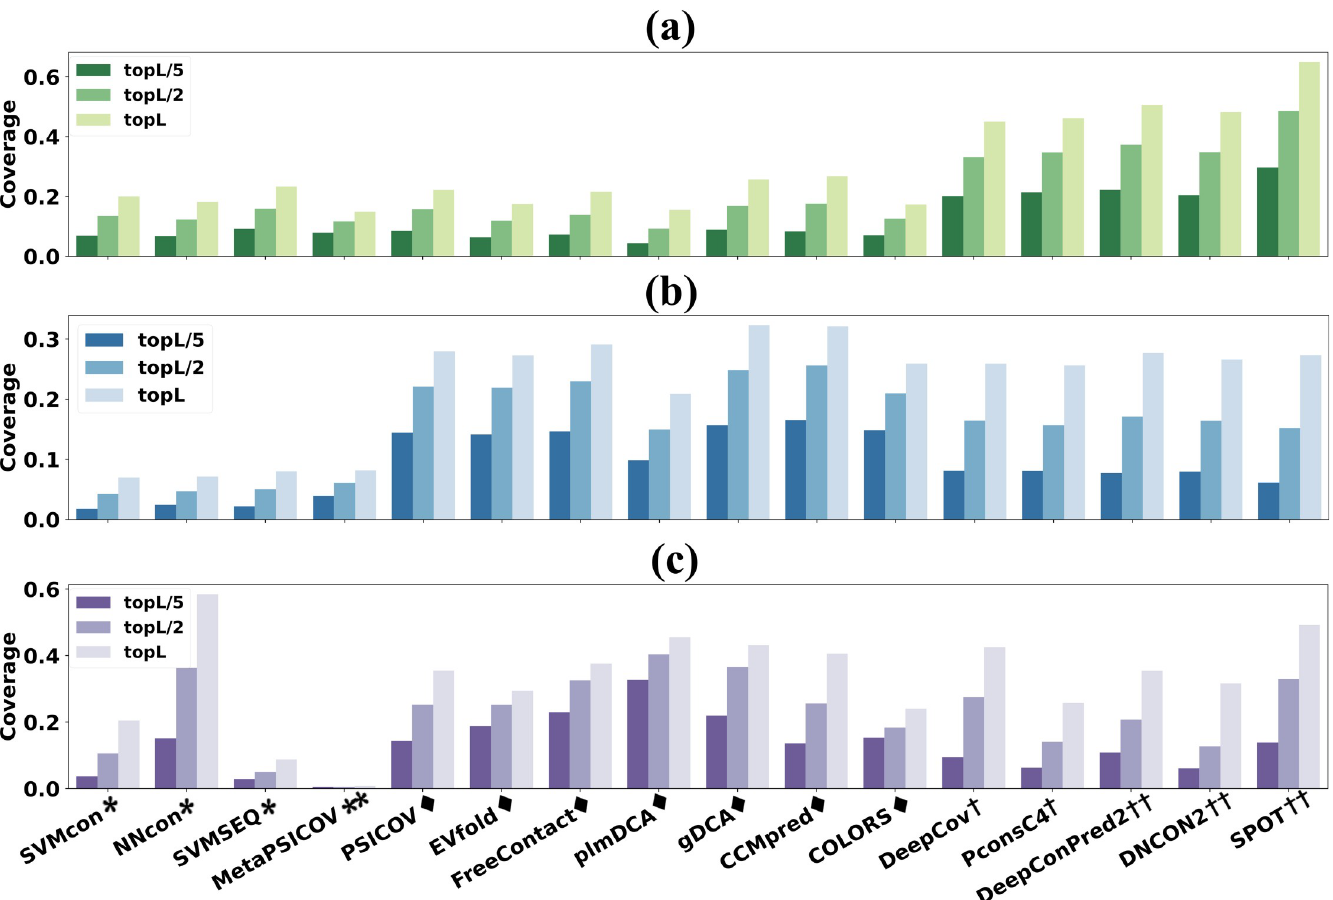
Fig 6. Prediction coverages of 16 methods on TestSet1 for physicochemical interactions: (a) hydrophobic interactions (b) salt bridges (c) disulfide bridges. For top L/5 predictions, DL methods can predict more hydrophobic interactions while ECA methods predict more salt bridges and disulfide bonds.